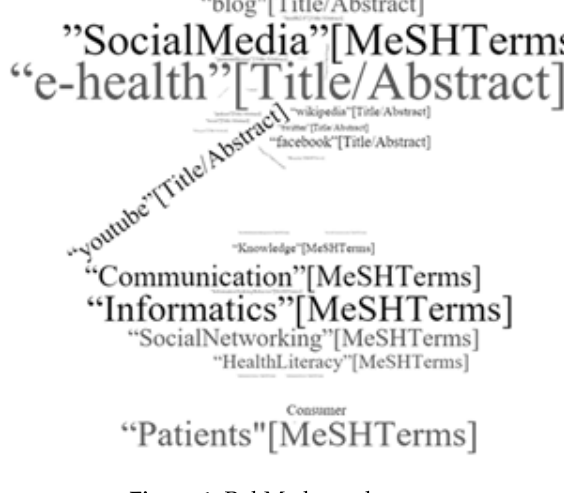
Figure 1. PubMed search strategy.